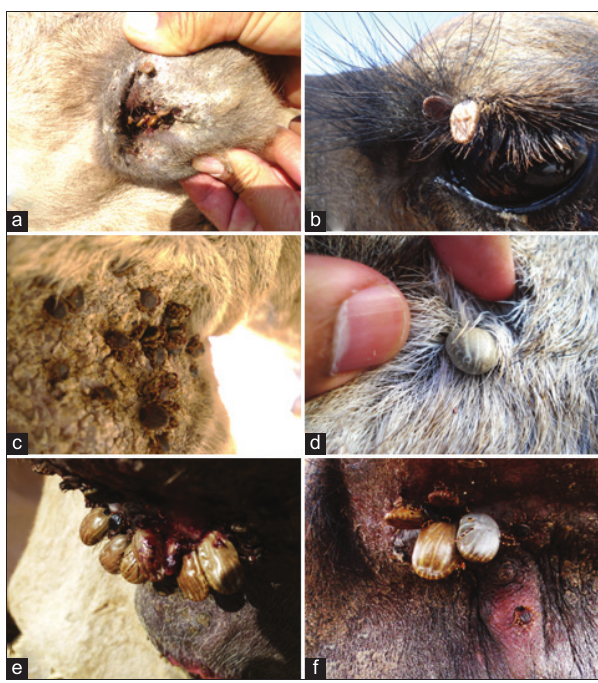
Figure-3: Hyalomma dromedarii ticks on different body parts of the camel: (a) Ear, (b) upper eyelid, (c) leg, (d) abdomen, and (e and f) tail